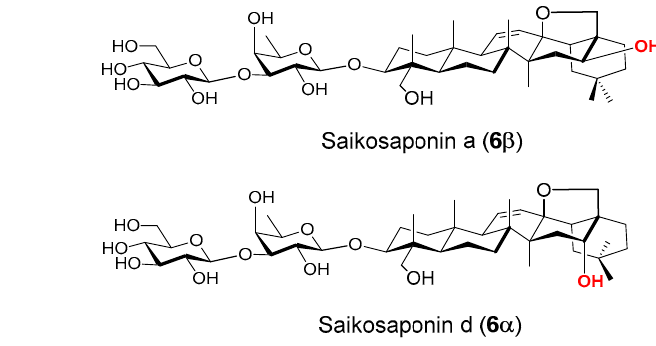
Figure 3. Immunostimulating natural saponins.